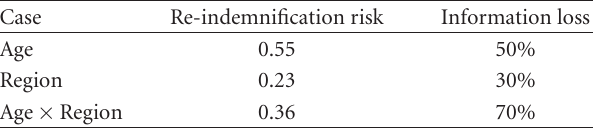
Table 1: Di ff erent cases in re-indemnification